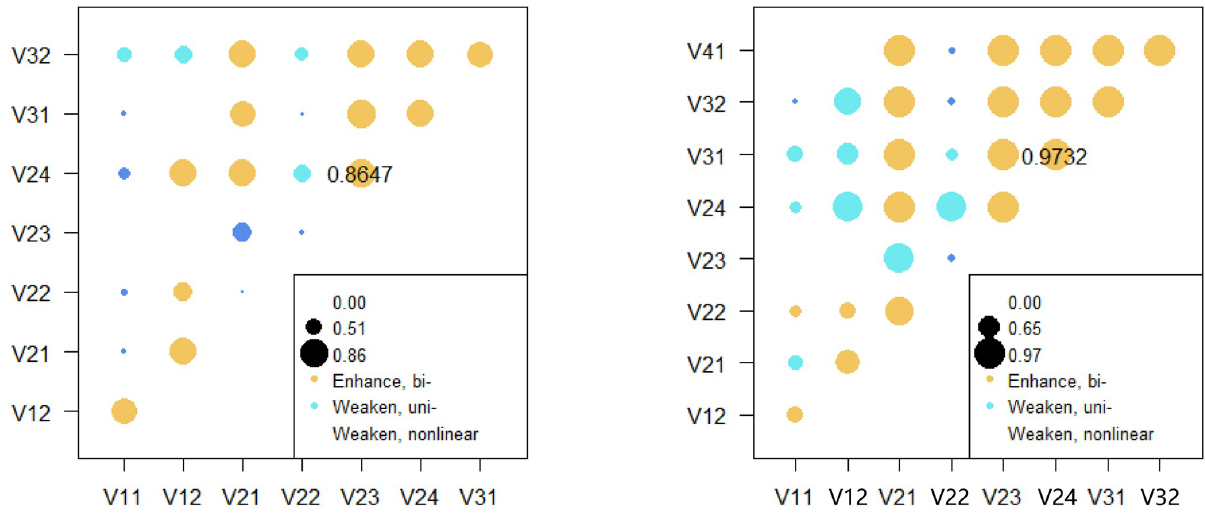
Fig 6. The interactions of factors on the spatial pattern of (a) tourism resources and (b) number of tourists on Hainan Island.